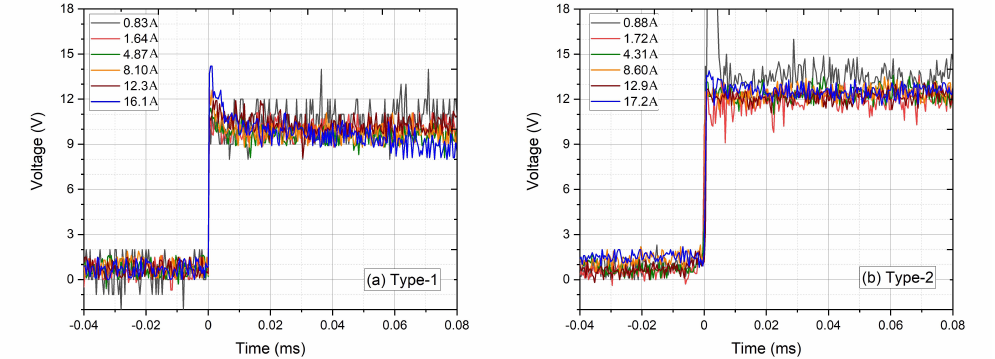
Figure 8. Arc voltage in the range of contact separation instant for ( a ) Type-1; ( b ) Type-2 contacts.